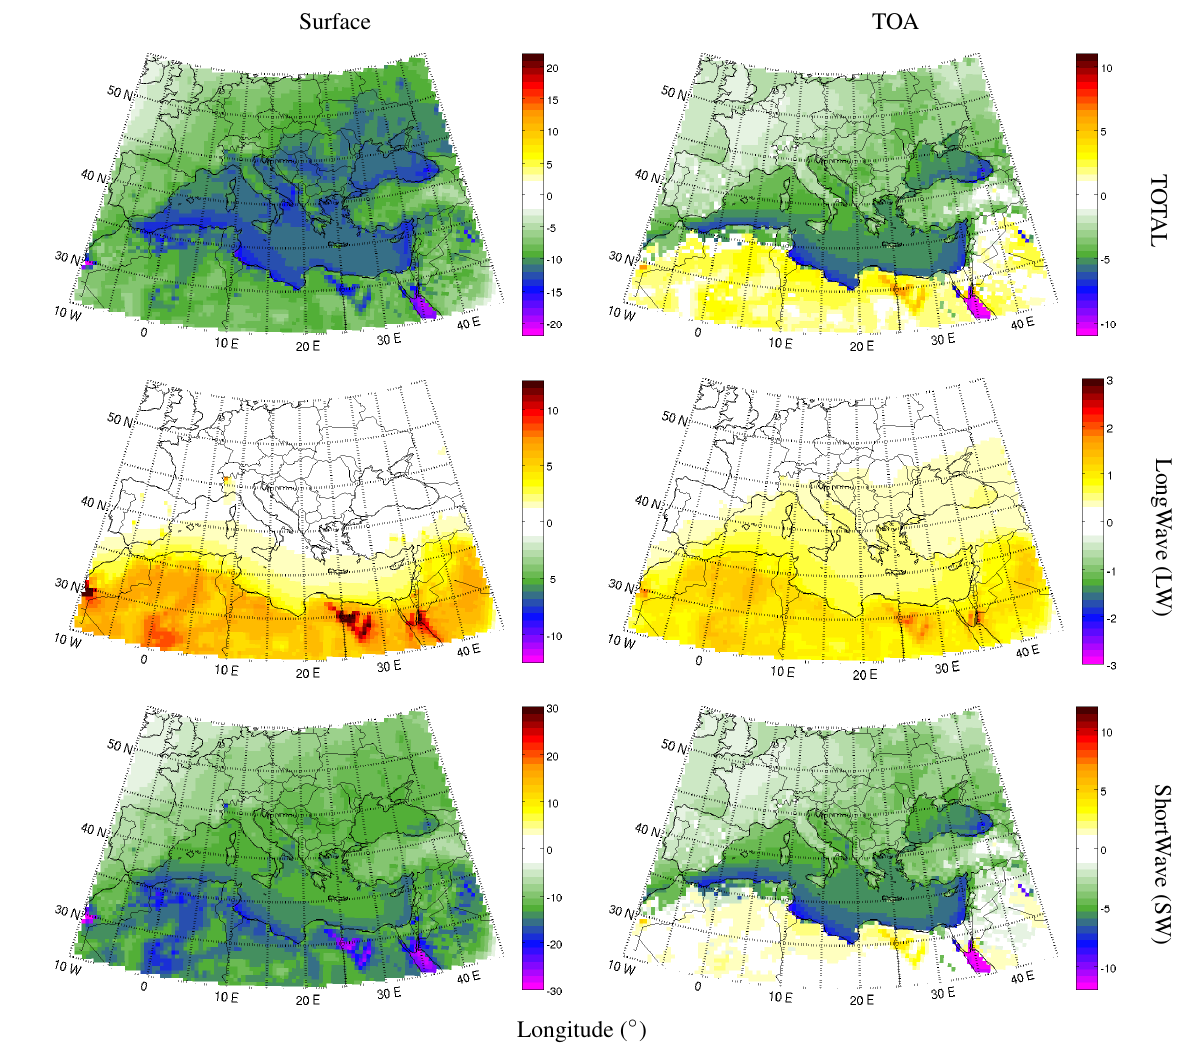
Fig. 14. Direct radiative forcing (in Wm − 2 ) simulated in NEW 2000–2009, at the surface (left panels) and at the top of the atmosphere (TOA, right panels), for total (top panels), longwave (middle panels) and shortwave (bottom panels) radiations. dust size distribution could also change the bioavailable iron fraction (Ito et al., 2012), which depends on the deposited dust size (Mahowald et al.,